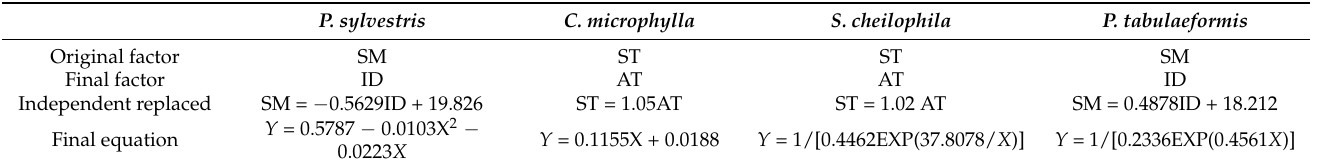
Table 3. Final prediction models of C mic /C org .